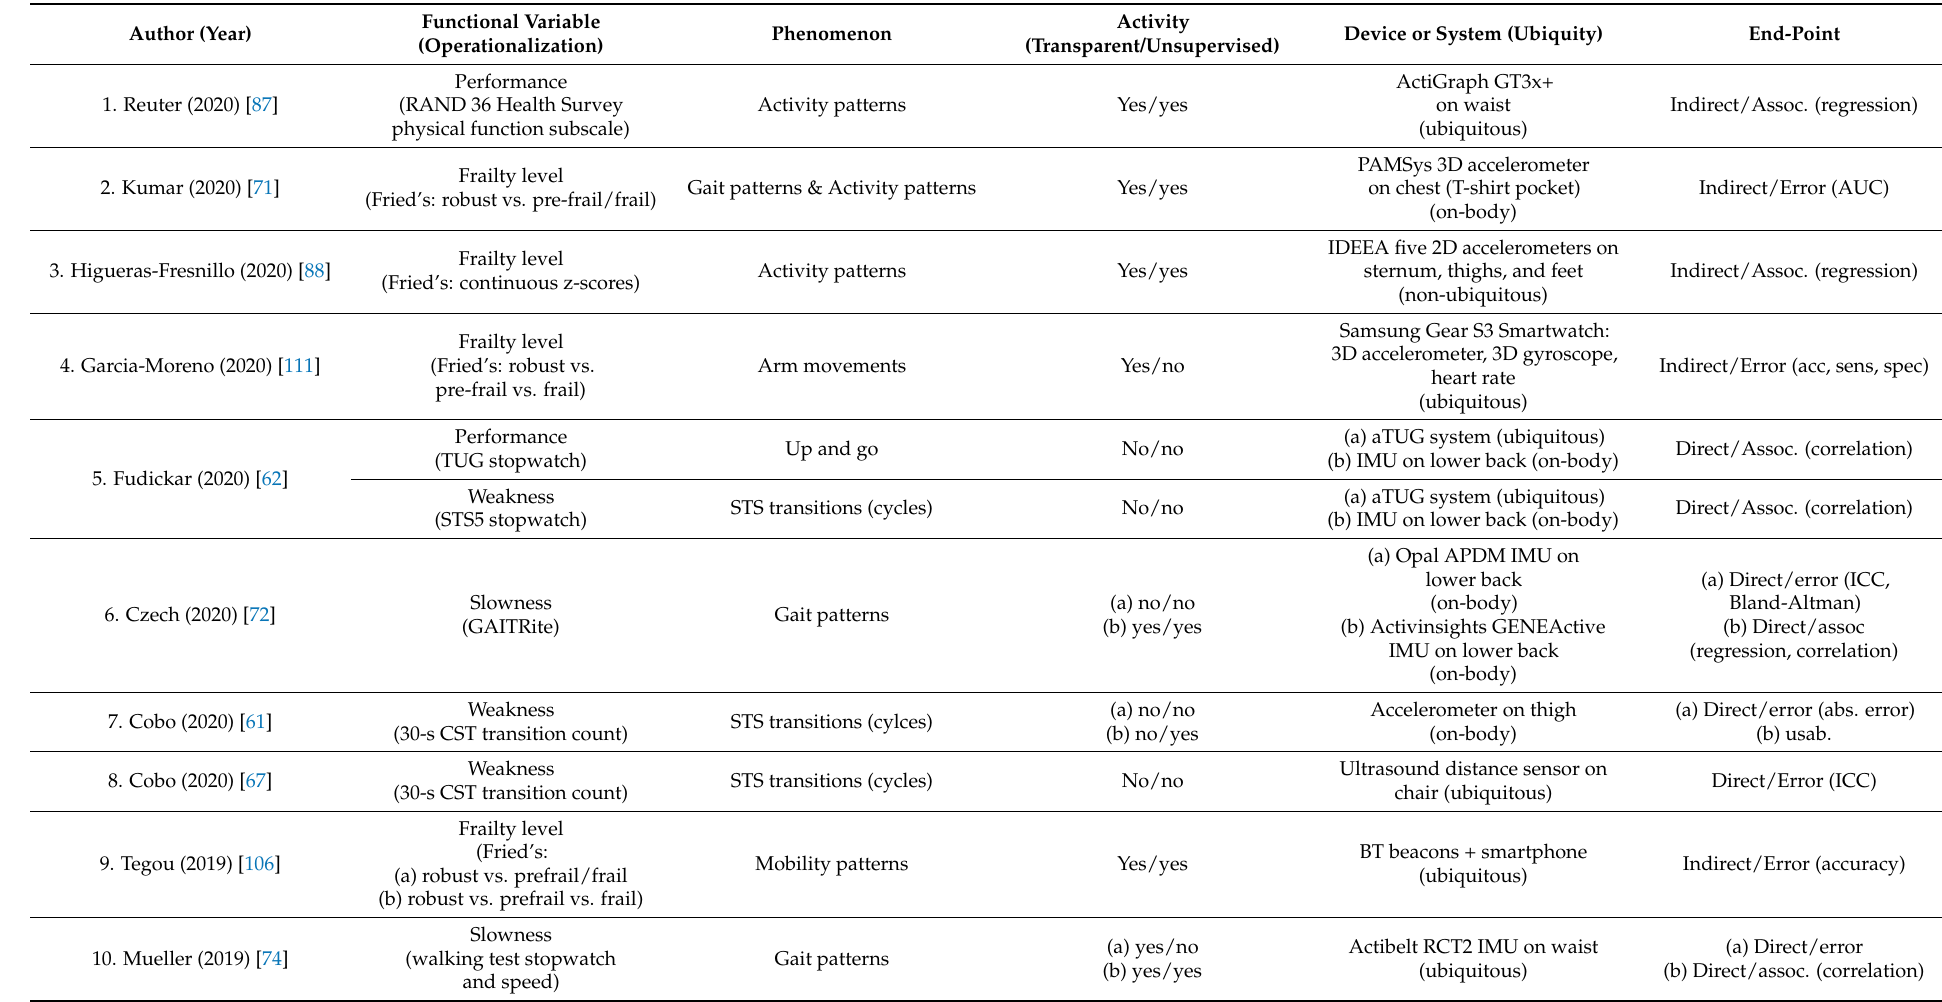
Table A1. Descriptive summary of the